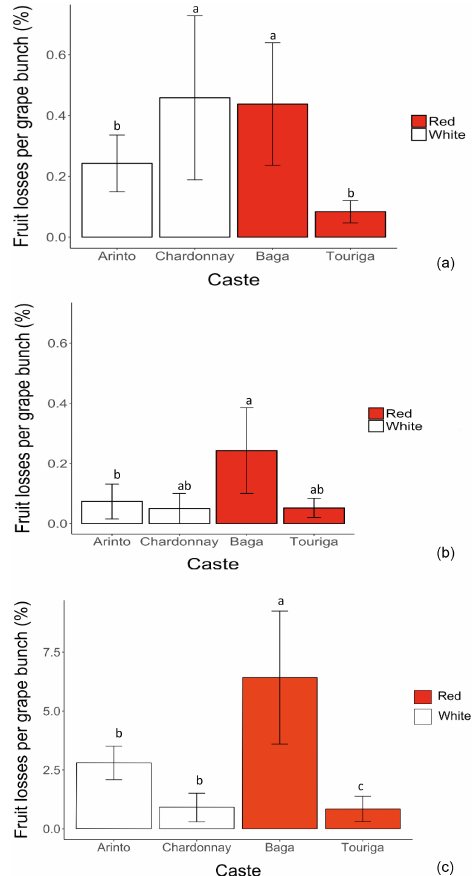
Figure 5. Percentage of fruit loss by insects (a) , birds (b) and fungi (c) per caste. Bars with the same letters do not differ signifi- cantly. Error bars represents the standard